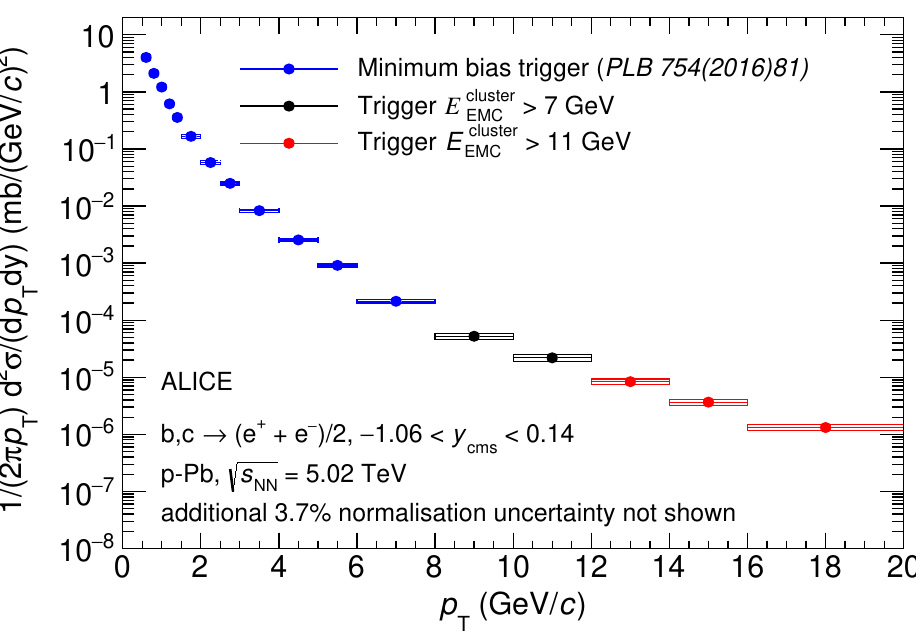
Figure 4 . The p T -di(cid:11)erential invariant cross section of electrons from heavy-(cid:13)avour hadron decays p in p-Pb collisions at s NN = 5 : 02 TeV. The statistical uncertainties are indicated for both spectra by error bars and the systematic uncertainties are shown as boxes. The published result is shown for 0 : 5 < p T < 8 GeV =c [33], and the measurement using the EMCal trigger is shown up to p T = 20 GeV =c